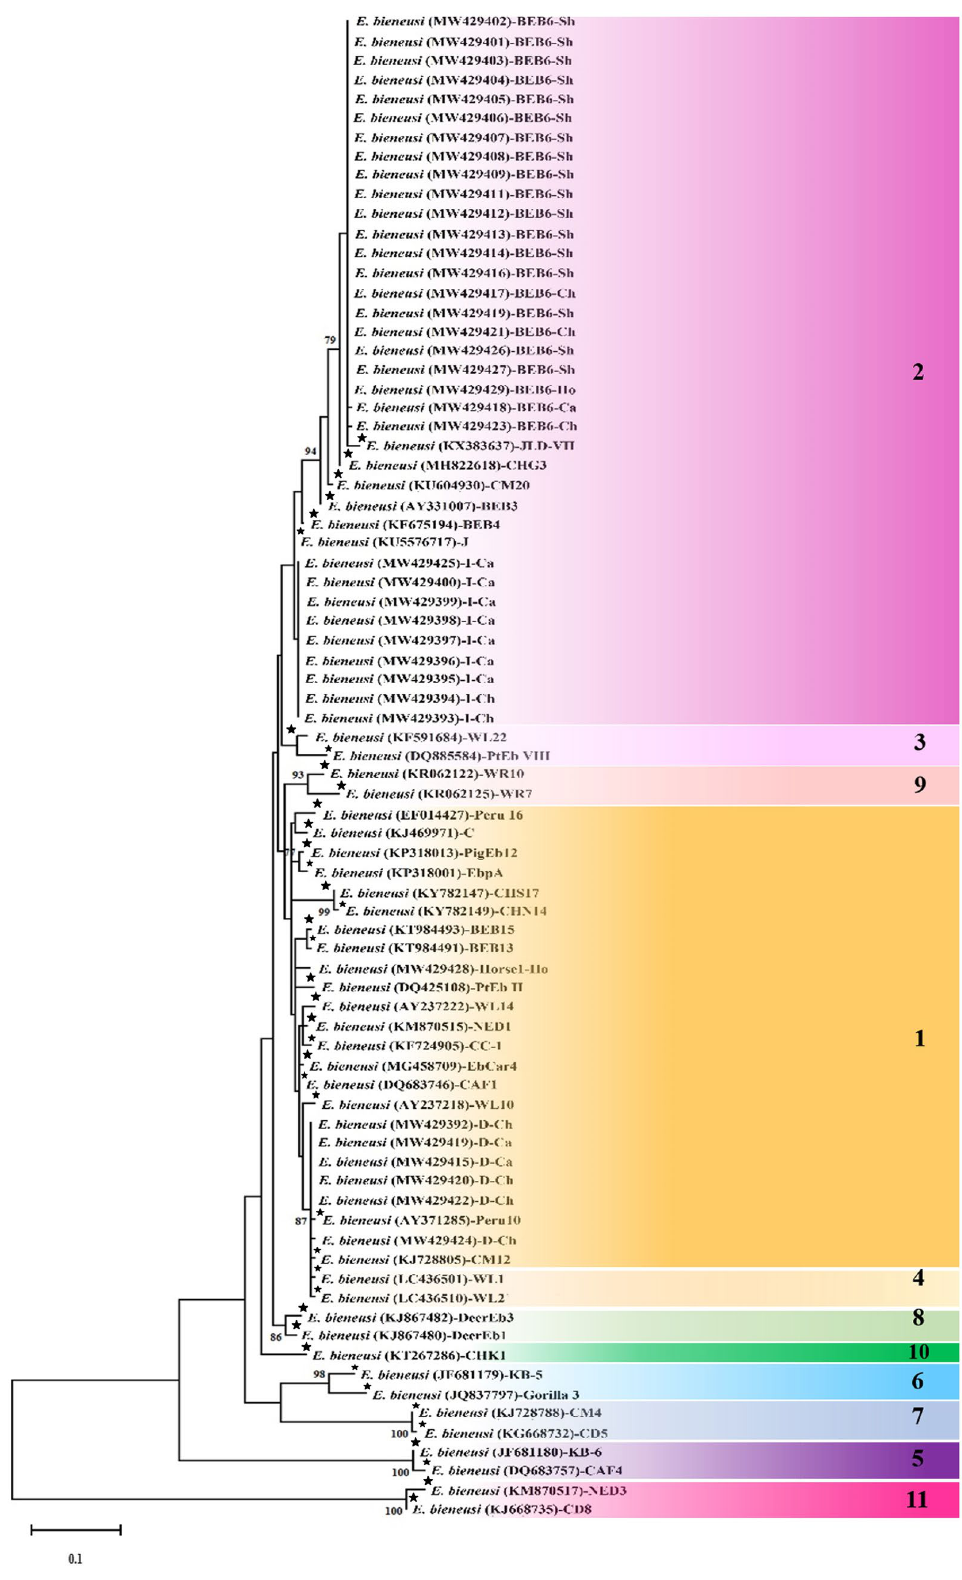
Figure 1. Phylogenetic tree of the ITS gene for E. bieneusi isolated from cattle, sheep, chicken, and horses together with reference sequences represents that all identified genotypes were cluster in two groups: 1 (1a and 1e) and 2 (2b and 2c). The phylogenetic tree was drawn using the maximum-likelihood method and the Tamura 3-parameter model. Bootstrap support (%) values of > 75% are indicated above the branches. Asterisks indicate reference genotypes. Sh: Sheep; Ca: Cattle; Chi: Chicken; Ho: